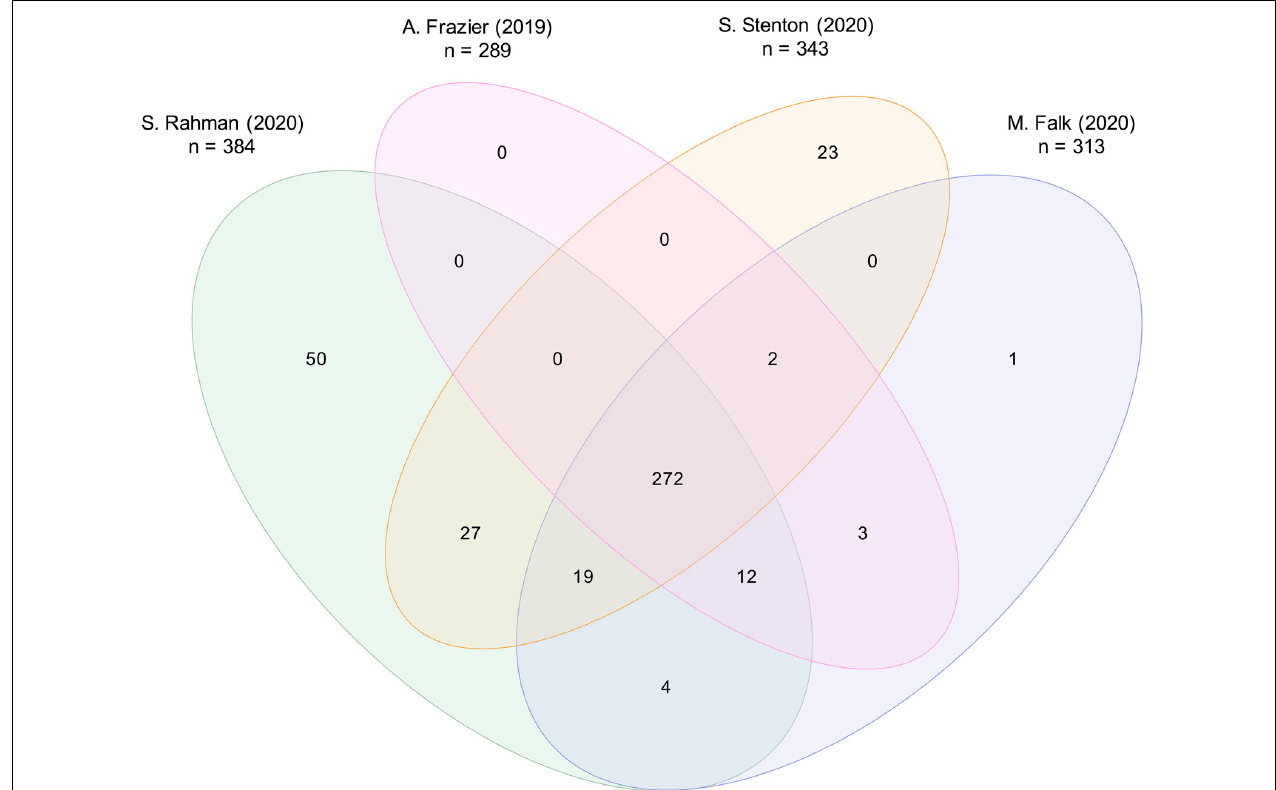
FIGURE 1 | Comparison of four distinct mitochondrial disease gene lists. Mitochondrial disease gene lists of (1) Frazier et al. (2019), listing 289 genes, (2) Rahman (2020), 384 genes, (3) Stenton and Prokisch (2020), 343 genes, and (4) Falk (2020), 313 genes, were compared. A total of 413 distinct genes was reported. A core of 272 mitochondrial disease genes was listed by all four